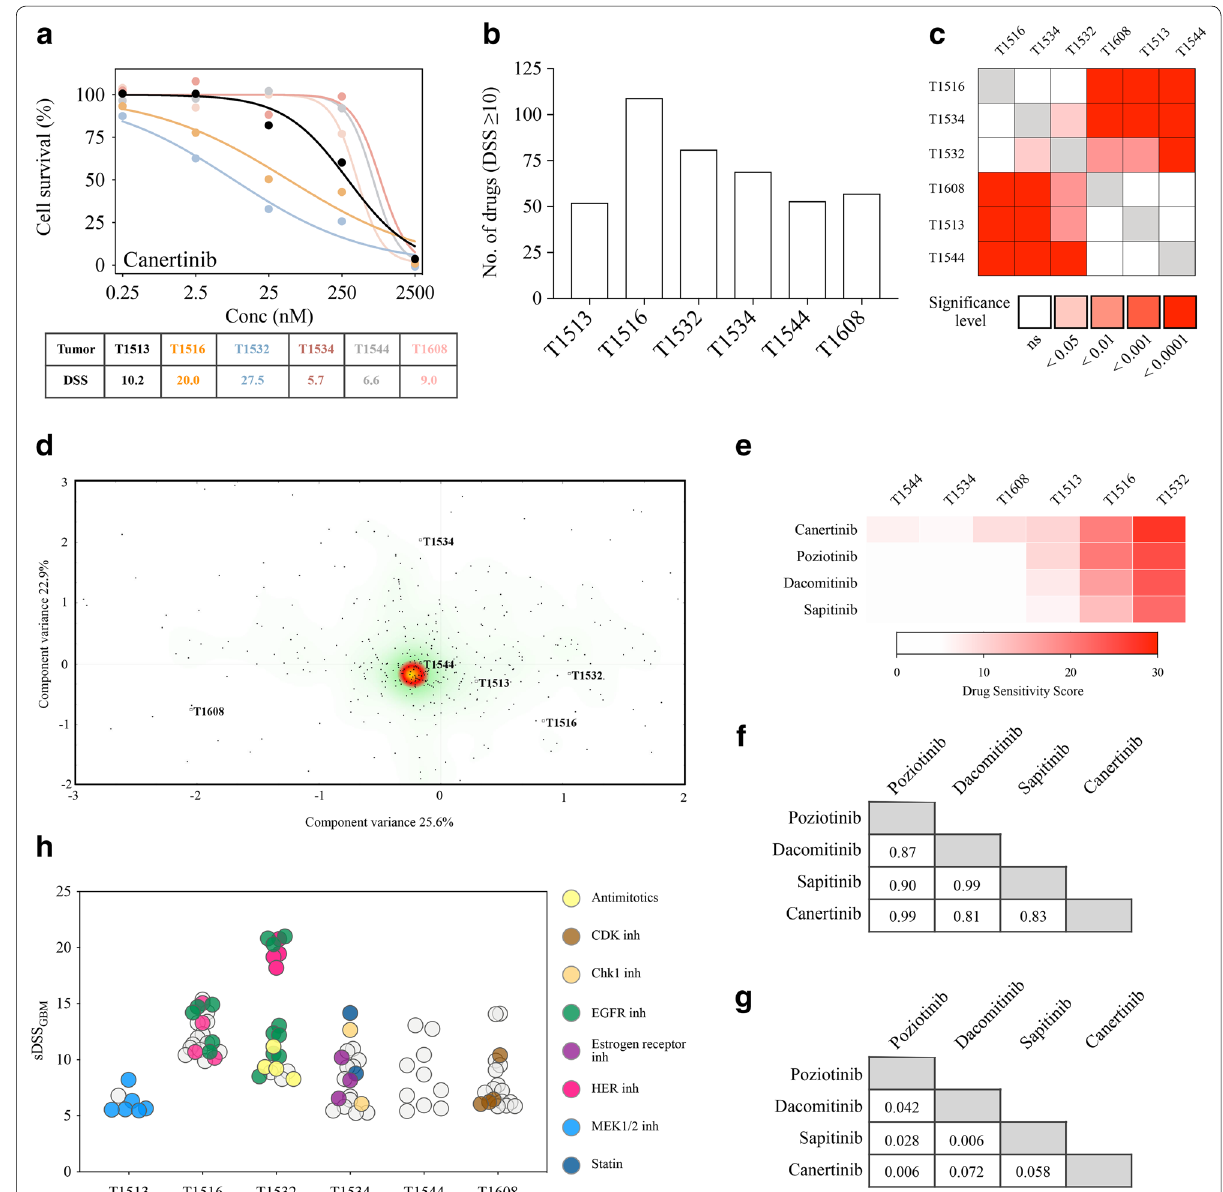
Fig. 3 Heterogeneity in drug sensitivity in recGSCs. a Dose–response curves of the pan‑HER inhibitor canertinib display the variation in drug efficacy in the recGSC cultures. Three responses are classified below the threshold for moderate activity (DSS 10). b Distribution of the number of ≥ drugs displaying a DSS 10 across the recGSC cultures. c Using a non‑parametric one‑way ANOVA of ranks, a significant difference was observed ≥ in the overall drug sensitivity across the cultures (p < 0.0001). According to the individual culture’s sensitivity to the entire drug collection (n 525 = drugs), they separated into two major clusters as the most and least sensitive. d Clustering of recGSC cultures by correspondence analysis based on all drug responses (n 525) in all tumors (n 6). The dots in the scatter plot represents the drugs in the DSRT and the color shading represent = = a heat map of where the average of the data is located. The scattering of tumors in the plot display both how they differ from the average and how tumors cluster together based on similarities in drug sensitivity patterns. e In the DSRT there were four pan‑HER inhibitors that displayed a DSS 10 in recGSC cultures. f The consistency of T1532 being the most sensitive and T1544 the most resistant displayed an excellent correlation ≥ in correlation matrices (Spearman, ρ). g p‑values in the correlation matrix of the pan‑HER inhibitors. h Selecting for drugs with at least moderate 5) the distribution of individual classes of drugs with selective efficacy revealed a efficacy (DSS 10) and increased patient‑selectivity (sDSS GBM ≥ ≥ considerable tumor heterogeneity in drug sensitivity in recGSC